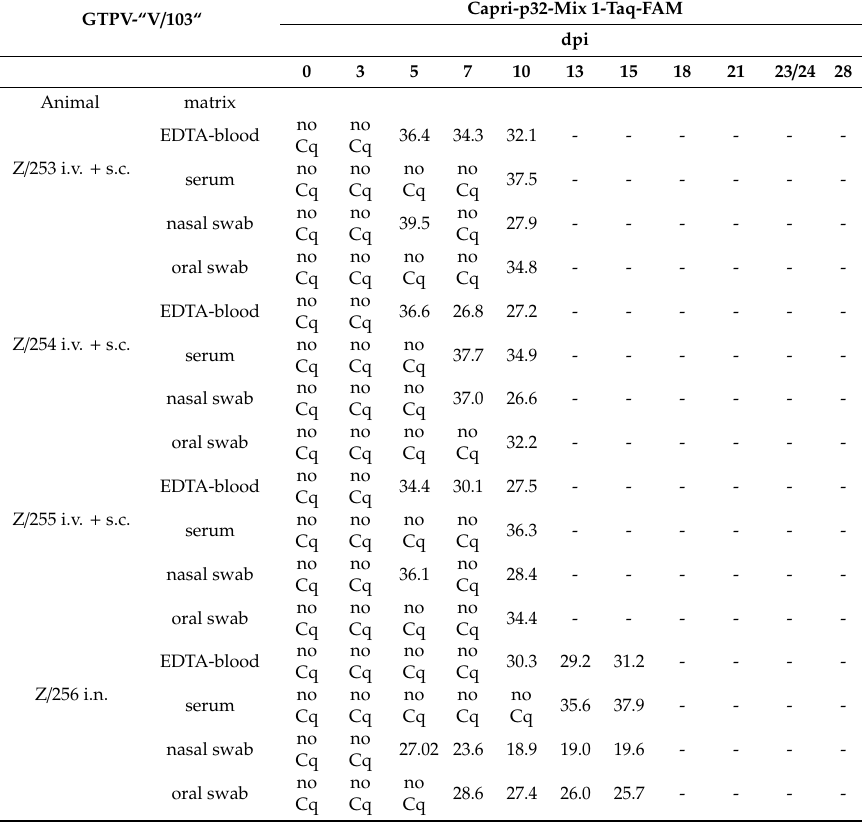
Table 2. Results (Cq values) of EDTA-blood, serum, nasal and oral swabs taken from goats inoculated with GTPV-“V / 103“ analyzed via pan Capripox real-time qPCR.